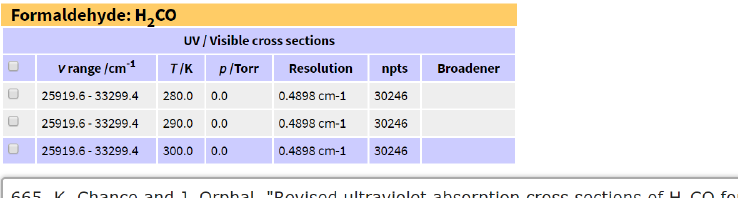
Figure 5. The bibliography pop-up for a given temperature-pressure (T-p) absorption cross section of formaldehyde. In this example, the cursor is over the third entry of the table. The number 665 to the left of the bibliography is the corresponding “global” ID integer, and the two hyperlinks at the end will take the user to the full-text article on the publisher’s website or ADS,